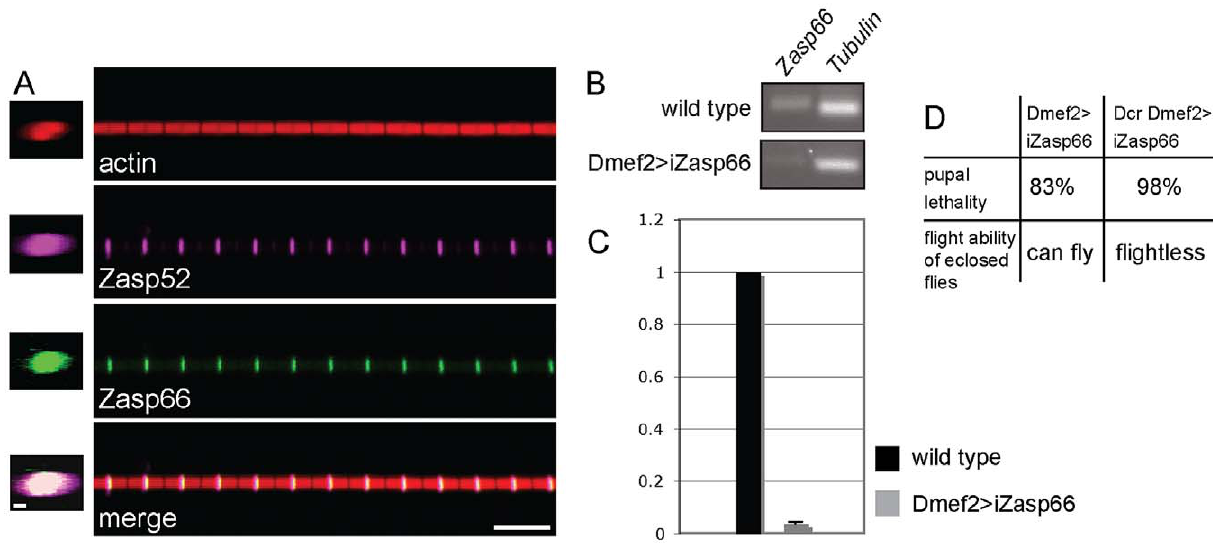
Figure 6. Zasp66 localization and iZasp66 phenotype. (A) Zasp52 and Zasp66 precisely co-localize at the Z-disc. Co-immunostaining of a Zasp66-GFP IFM myofibril with phalloidin and anti-Zasp52 antibody. Zasp66-GFP was detected by GFP fluorescence. Z-stacks on the left show Zasp52 and Zasp66 across the diameter of the myofibril. Scale bar left panels, 0.5 m m. Scale bar right panels, 5 m m. (B) RT-PCR of Zasp66 and Tubulin from wild type and Zasp66 RNAi knockdown flies at 29 u C. (C) qPCR of Zasp66 , Tubulin , and rp49 from wild type and Zasp66 RNAi knockdown flies at 29 u C. Numbers on the y axis refer to averaged ratios of Zasp66 mRNA to Tubulin and rp49 mRNAs (normalized to 1 for wild type). (D) Phenotype of RNAi- mediated knockdown of Zasp66 with or without Dcr scored at 29 u C.